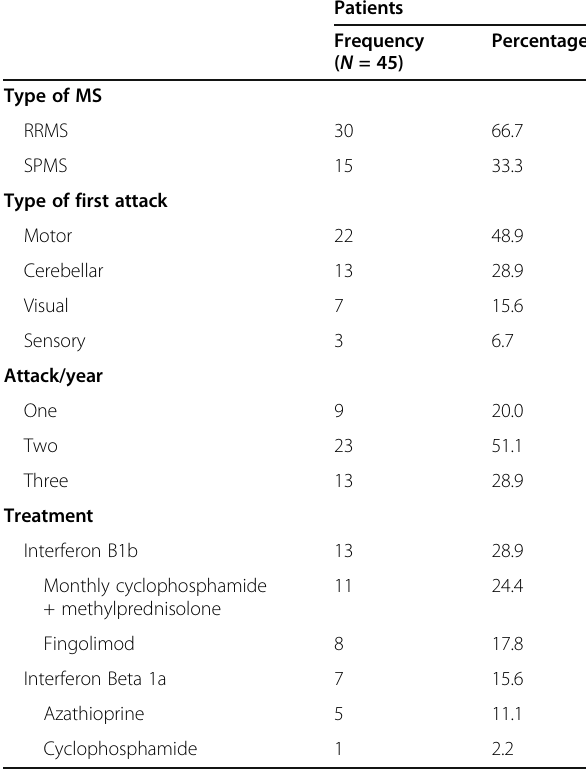
Table 1 Clinical characteristics of MS patients